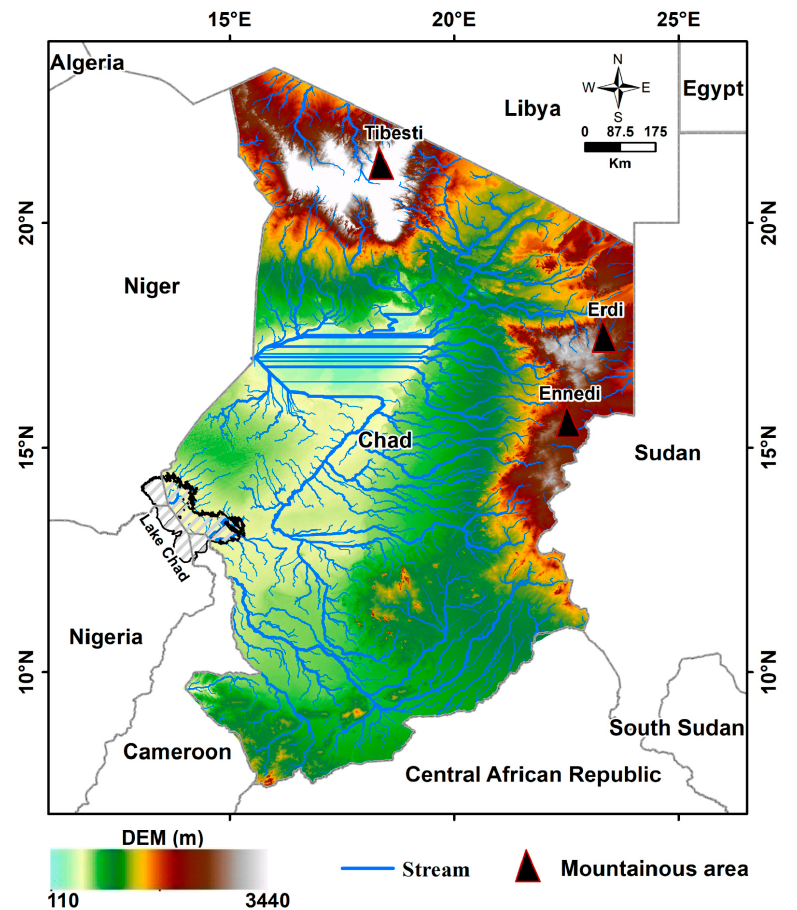
Figure 12. A map illustrating the local stream networks as well as the surface elevation of Chad using a digital elevation model (DEM). a digital elevation model